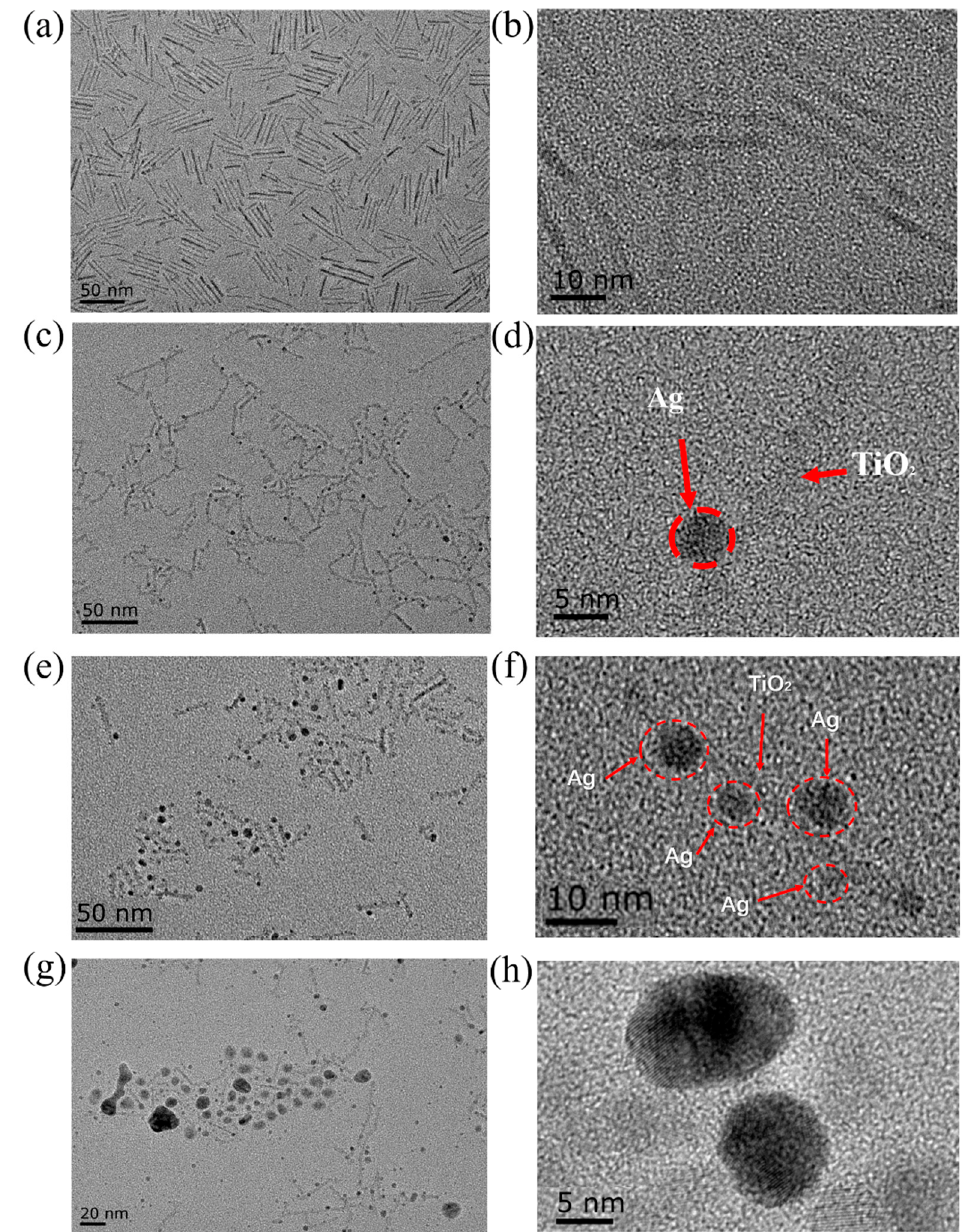
Figure 2. Characteristics of TiO 2 nanorods and Ag-TiO 2 nanorod composites. ( a ) TiO 2 nanorods and ( b ) a high-solution image. ( c ) Ag-TiO 2 nanorod composites with 60 min illumination of UV light (Sample 1) and ( d ) a high-solution image. ( e ) Ag-TiO 2 nanorod composites with 180 min illumination of UV light (Sample 2) and ( f ) a high-solution image. ( g ) Ag-TiO 2 nanorod composites with 300 min illumination of UV light (Sample 3) and ( h ) a high-solution image.